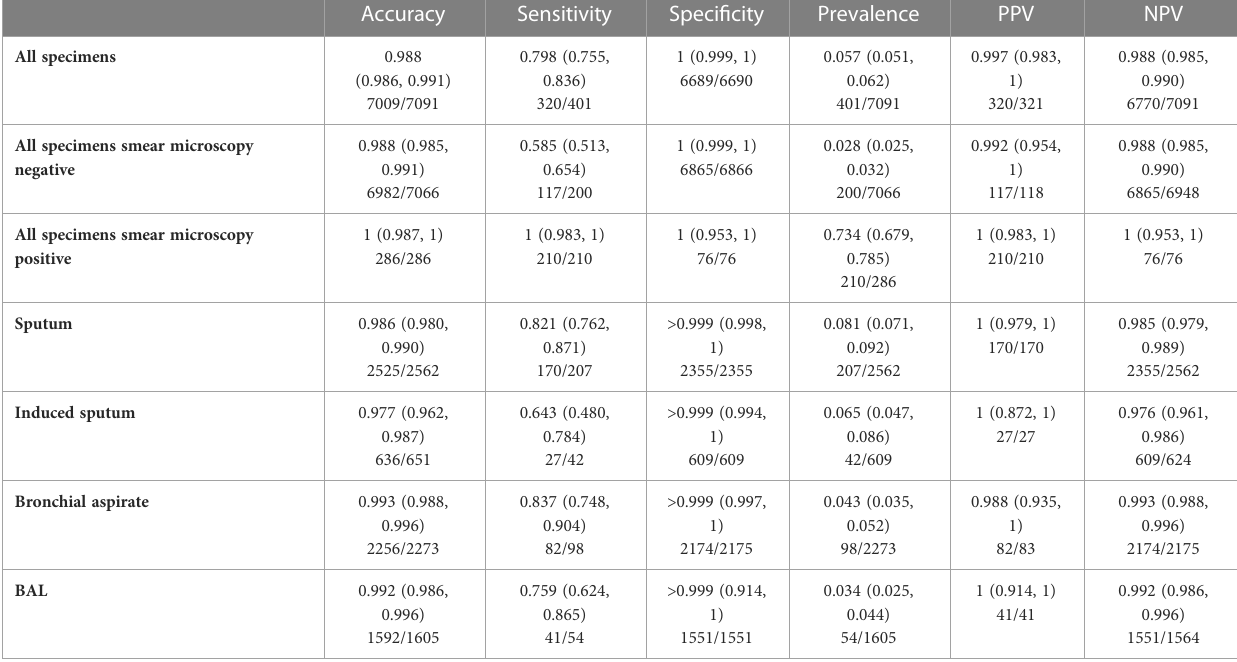
TABLE 2 Performance of PCR for the diagnostic of pulmonary tuberculosis according to the type of